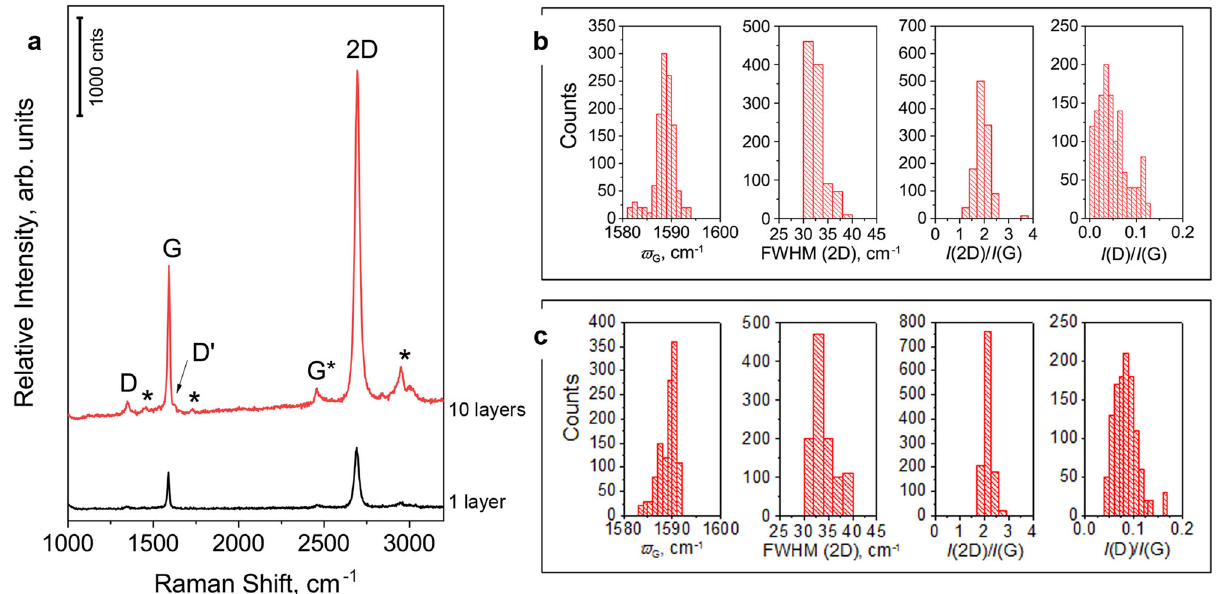
Fig. 2 Raman spectroscopy investigation of Gr/PMMA nanolaminates. a Representative Raman spectra collected from single and multiple graphene/ PMMA layers showing that monolayer character is retained after multiple depositions. Asterisks mark the spectroscopic features of the poly(methyl methacrylate). b Distributions of G peak position ( ω G ) , full width at half maximum of 2D peak (FWHM(2D)), intensity ratios I (2D)/ I (G) and I (D)/ I (G) for 1 Gr/PMMA layer and c for 10 Gr/PMMA layers.